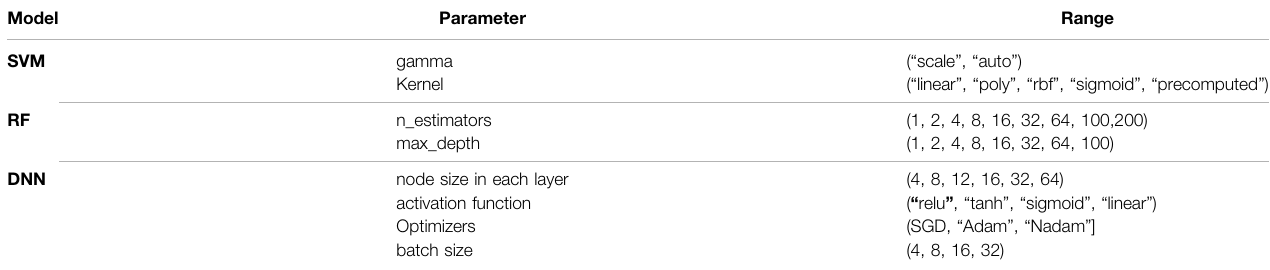
TABLE 2 | Parameter search space for optimizing SVM, RF, and DNN models (Bold fond indicates the selected value).